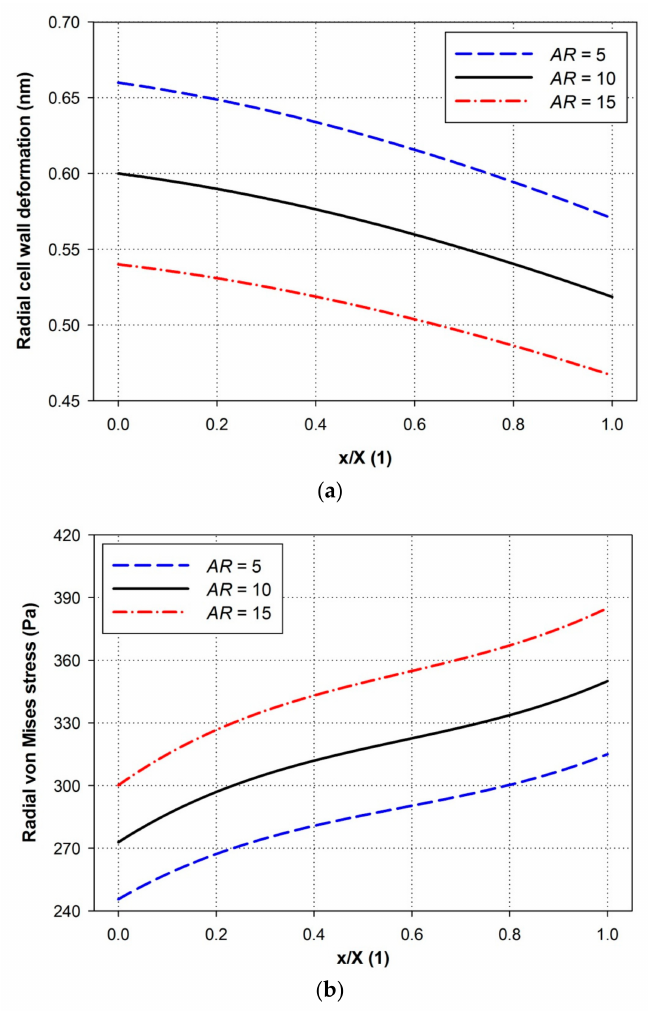
Figure 7. Effect of AR s on radial ( a ) cell wall deformation (nm) and ( b ) von Mises stress